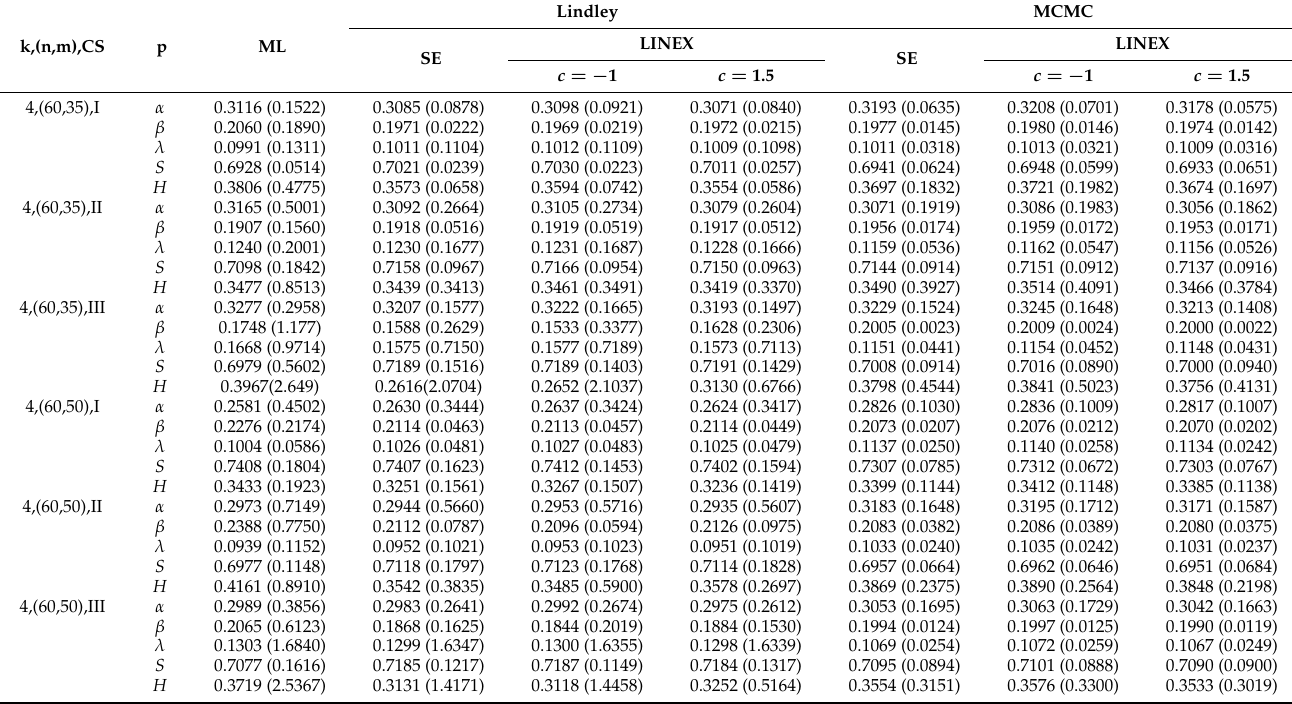
Table 4. AM and (MSE) of estimates for α , β , λ , S , and H